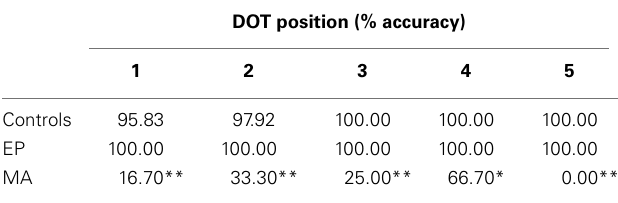
Table 4 | Comparisons between the accuracy (% correct) of each one of the two patients affected by USN and ND and four right-brain-damaged patients without USN and ND (controls), for each dot